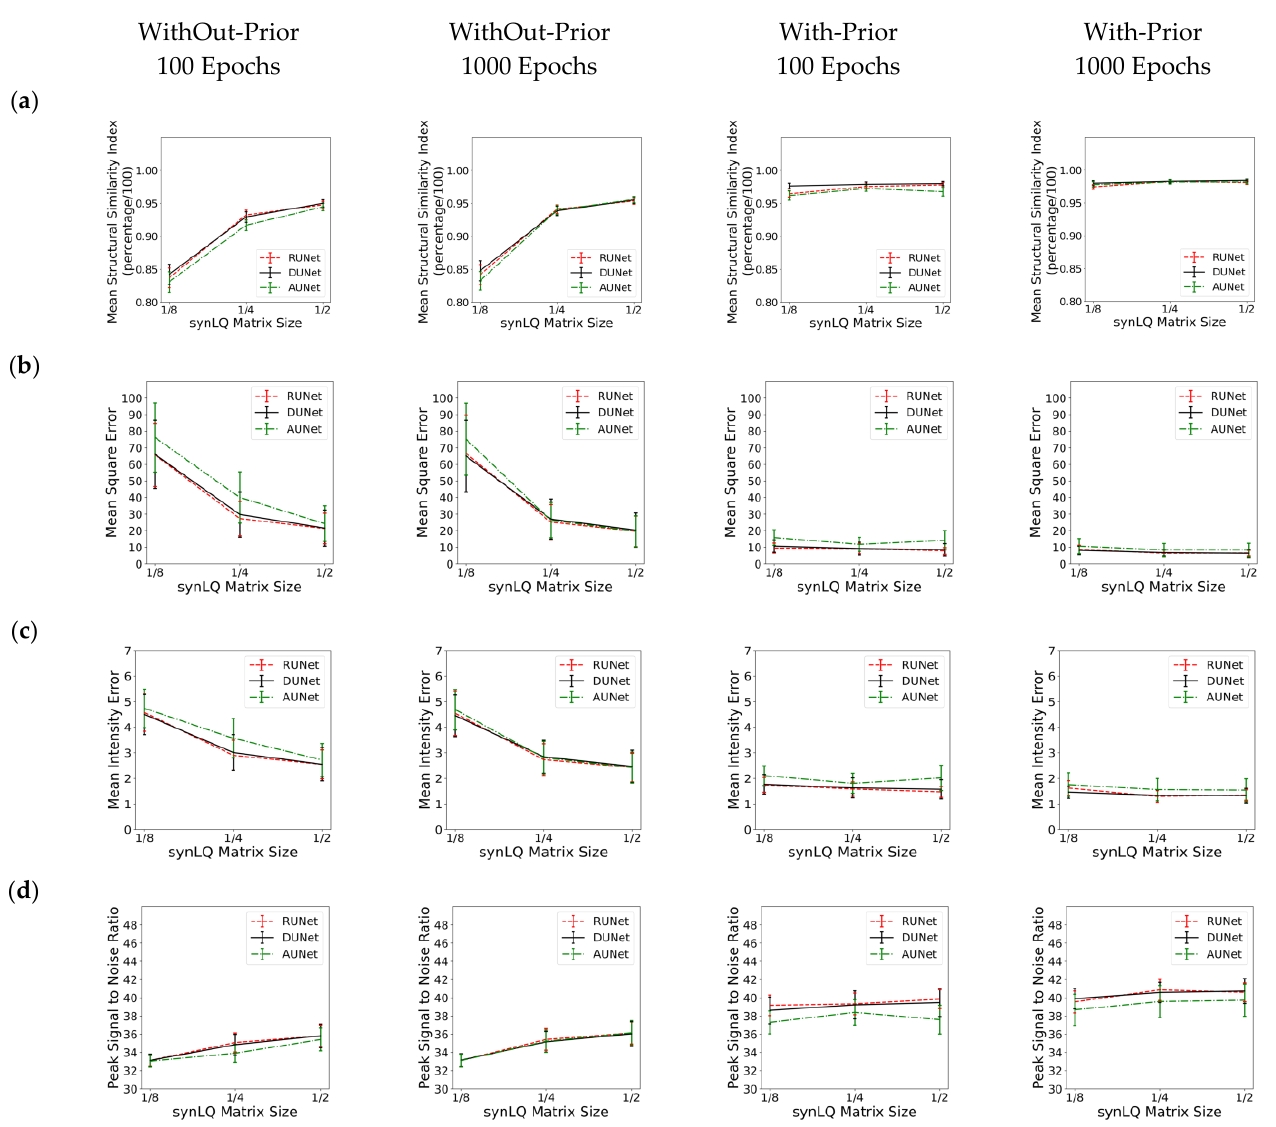
Figure 6. Performance of the three UNet architectures (RUNet in red, DUNet in black, and AUNet in Green) for the two With- and WithOut-Prior acquisition scenarios after training for 100 and 1000 epochs. ( a ) Mean Structural Similarity Index, ( b ) Mean Squared Error, ( c ) Mean Intensity Error, and ( d ) Peak Signal-to-Noise Ratio of reconHQ vs. synHQ, for different sizes of input synLQ images. The measures are reported as average (standard deviation) for N = 540 test images corresponding to 84 subjects.